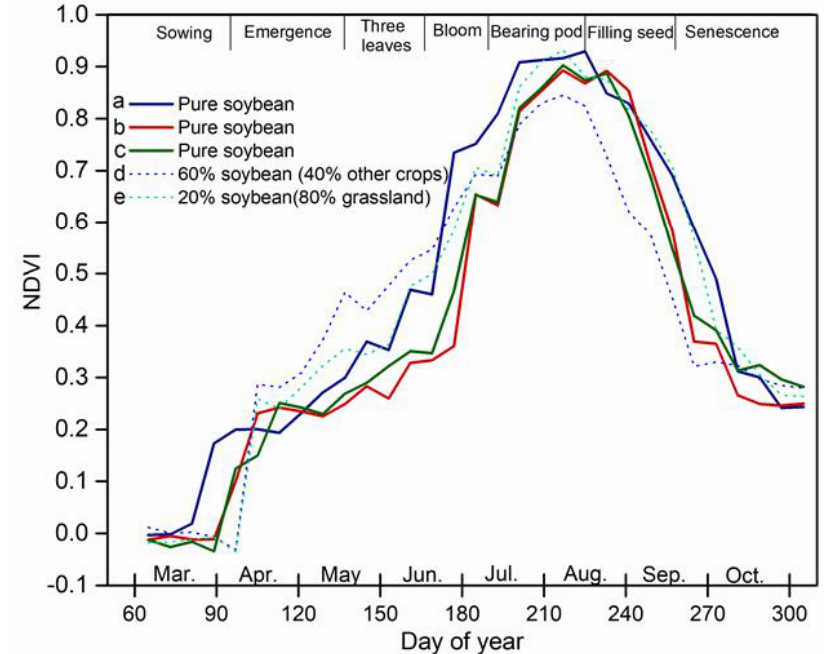
Figure 6. Time-series NDVI curves of pure soybean pixels ( a – c ) and mixed pixels ( d , e ) during the entire crop growing period in Heilongjiang. The specific spatial locations of those five pixels were described in Figure 1. These five pixels were presented here to show the time-series curve characteristics of different soybean fractions and to examine whether the distance of spatial locations is related to the variations of crop time-series spectral curves.